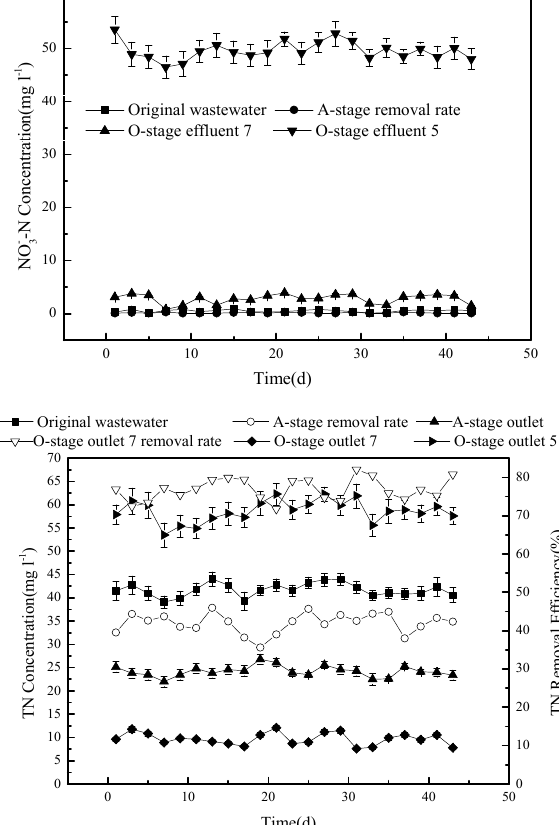
Figure 5. The changes of nitrate concentration ( top ) and of total nitrogen (TN) ( bottom ) during the